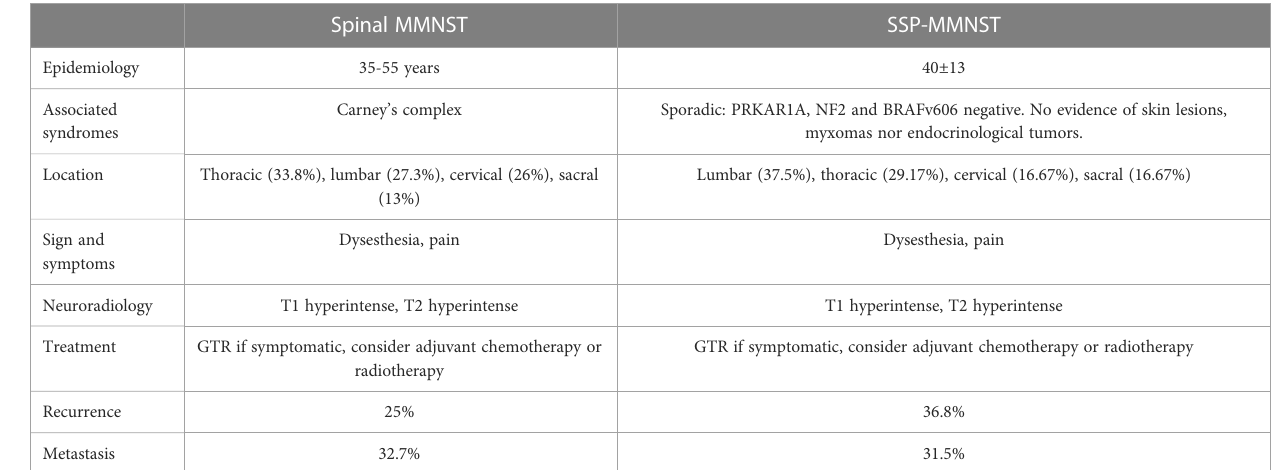
TABLE 2 Comparison of Spinal MMNST and